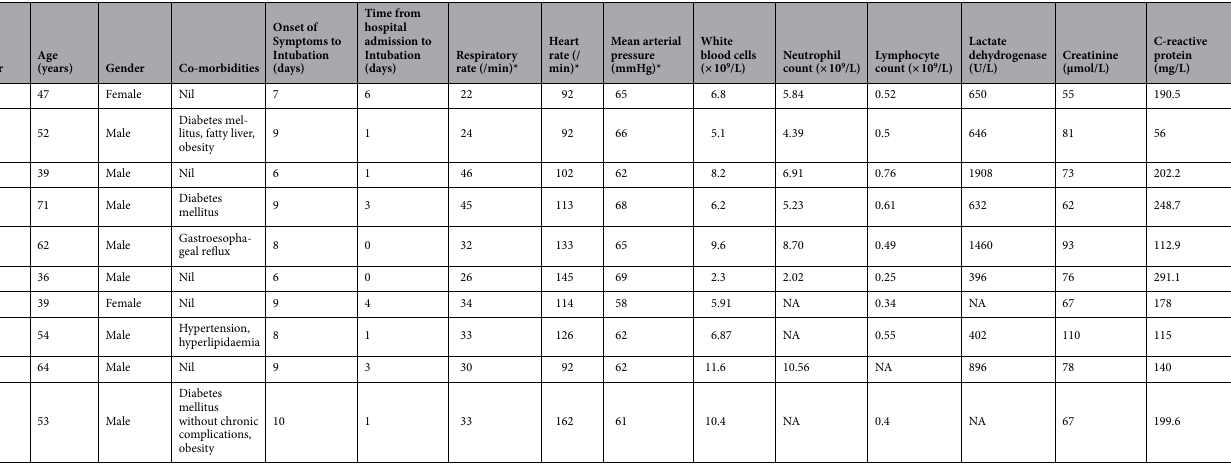
Table 2. Baseline characteristics and laboratory results of mechanically ventilated COVID-19 patients on day of ICU admission. NA not available. *Highest readings for respiratory rate and heart rate while lowest for mean arterial pressure in the first 24 h of intensive care unit